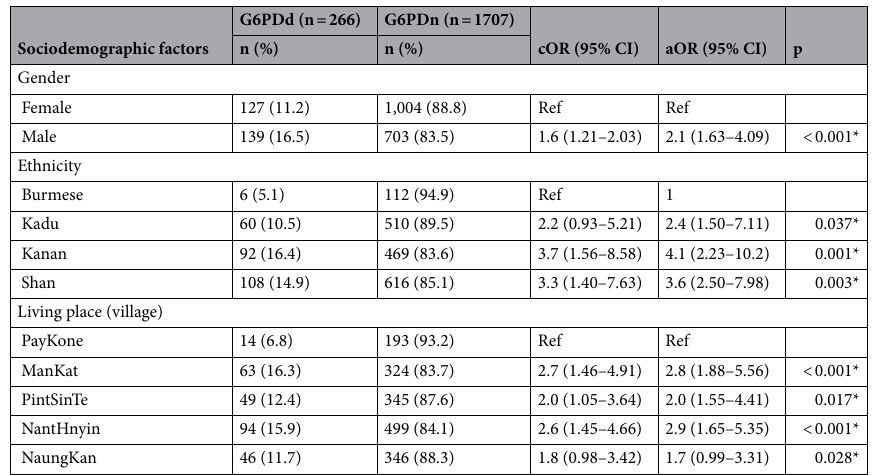
Table 2. G6PD deficiency prevalence and its associated demographic factors among participants included in the mass blood survey (n = 1973). G6PDd G6PD deficient, G6PDn G6PD normal, cOR crude odds ratio, aOR adjusted odds ratio, CI confidence interval, Ref. reference. *Significance at p <